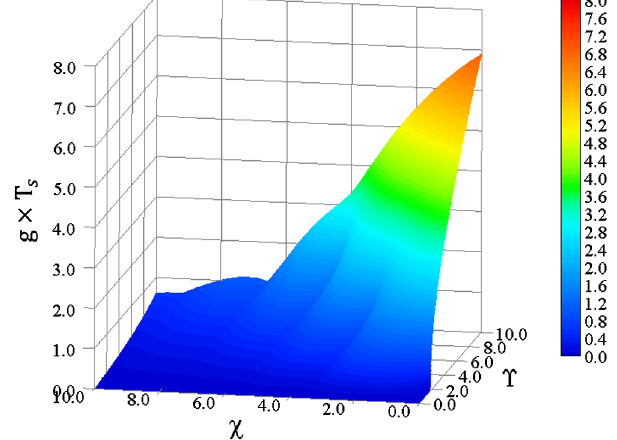
FIG. 14. The three-dimensional contour plot of the growth factor g × T (of the most unstable mode) as a function of ϒ and χ s at the rms bunch length of 2 cm in the trapezoidal wake model for the Vlasov analysis with the Gaussian bunch distribution.